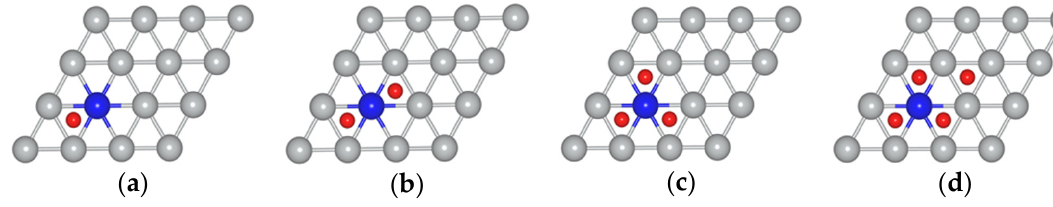
Figure 2. Top views of the most stable adsorption configurations for the oxygen coverage of ( a ) 1/9; ( b ) 2/9; ( c ) 3/9 and ( d ) 4/9 with Mo located at the top-most atomic layer of the slab. Only the top-most metal atomic layer and adsorbed O atoms are shown. Gray, blue and red balls represent Ni, Mo and O, respectively.